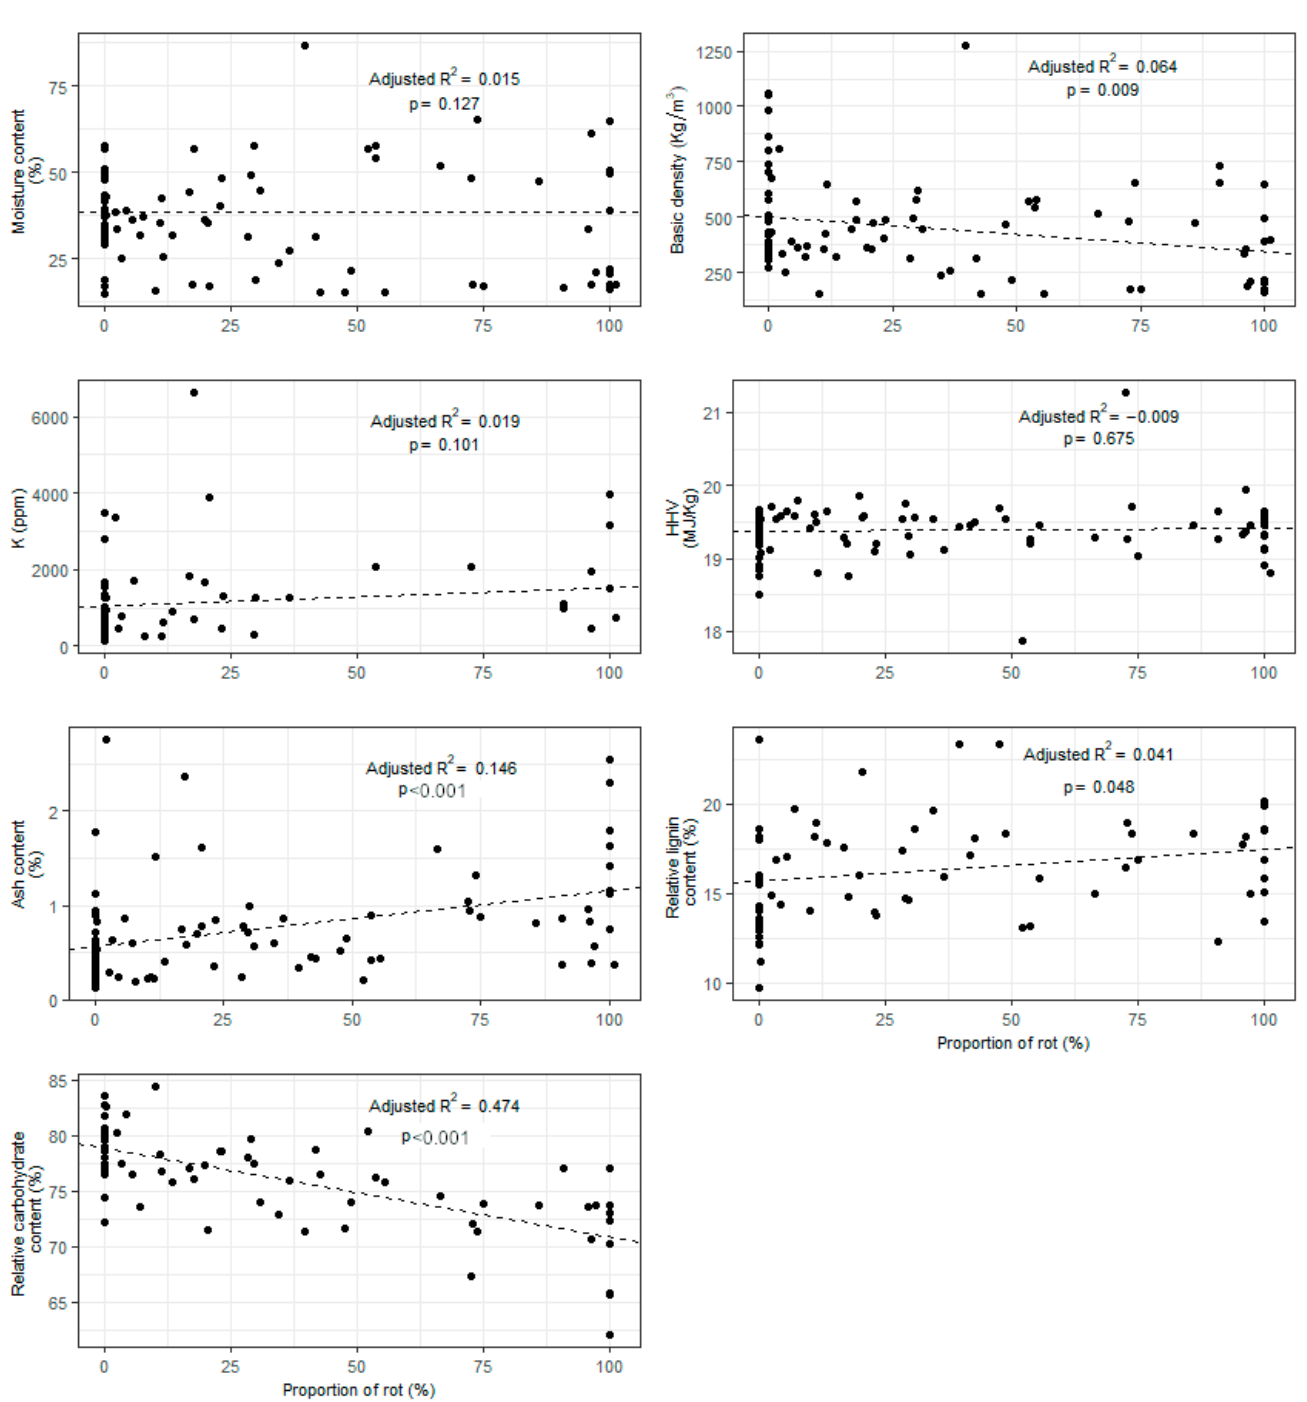
Figure 3. Relationships between proportion of wood area affected by rot and biomass properties.